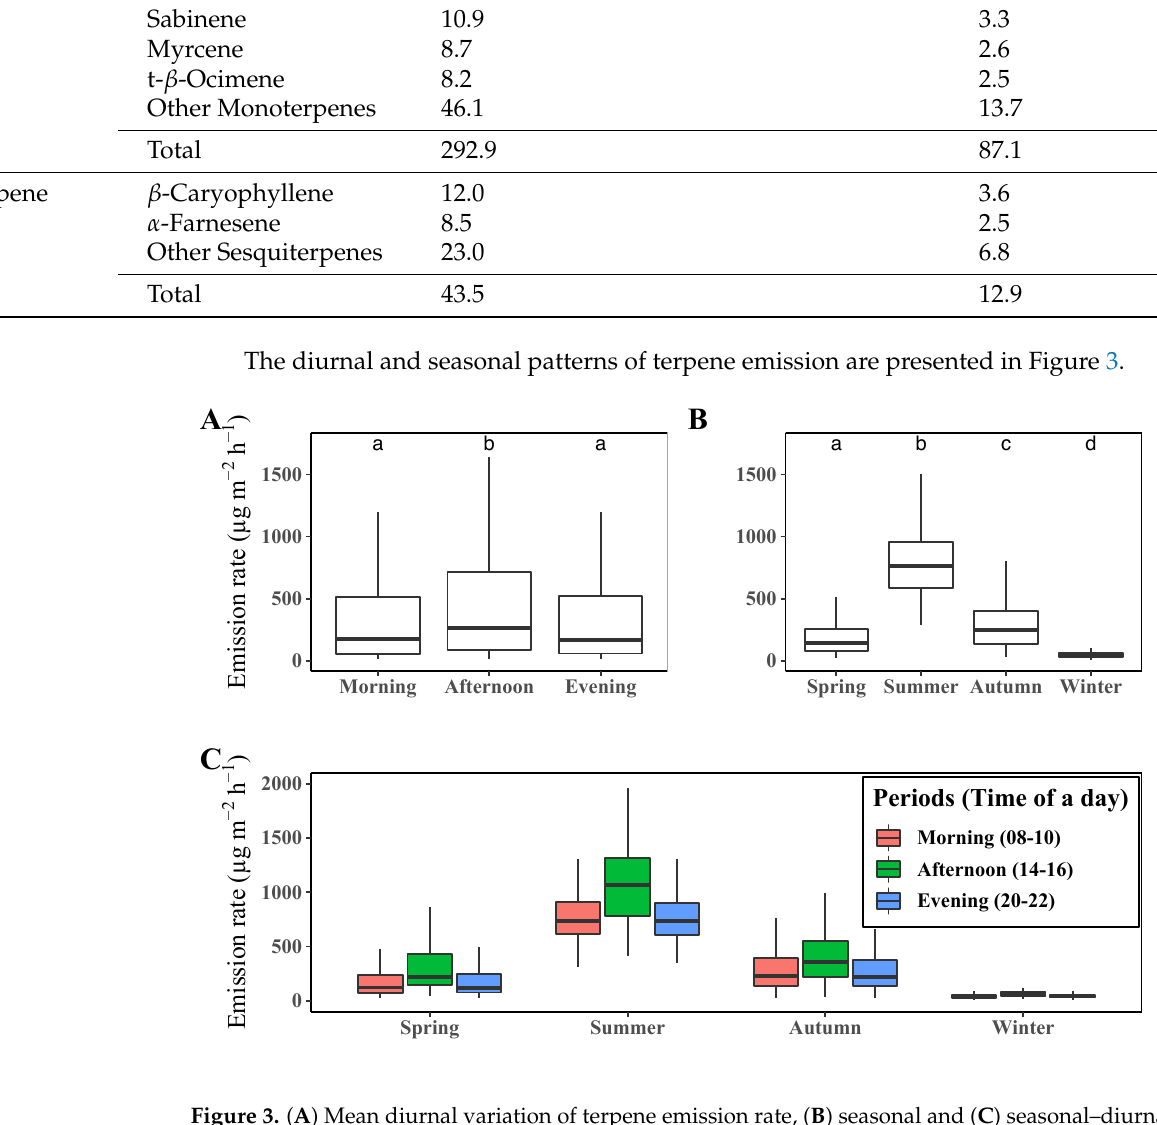
Figure 3. ( A ) Mean diurnal variation of terpene emission rate, ( B ) seasonal and ( C ) seasonal–diurnal comparison of the terpene emission rate of the year 2020 in Saneum-ri area. Different letters above the boxplots in A and B indicate significant differences (Dunn’s test p < 0.05) among mean values of terpene emission